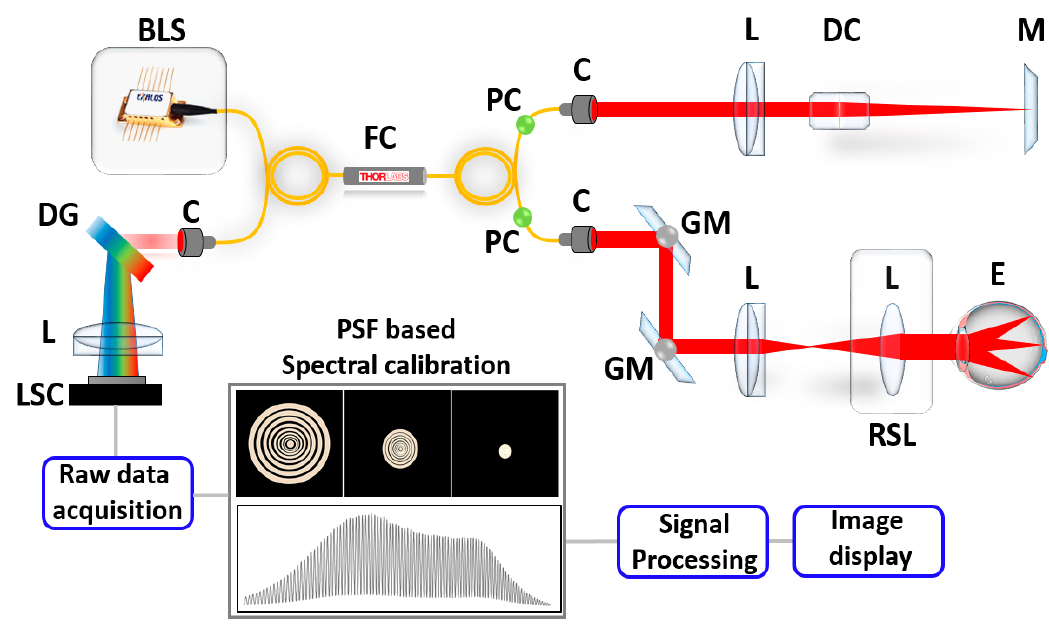
Figure 1. System configuration of the SD-OCT system. Abbreviations: BLS, broadband laser source; C, collimator; DG, diffraction grating; DC, dispersion compensator; E, eye; FC, fiber coupler; GM, Galvano mirror; L, lens; LSC, line scan camera; M, mirror; PC, polarization controller; RSL, retinal scanning lens.